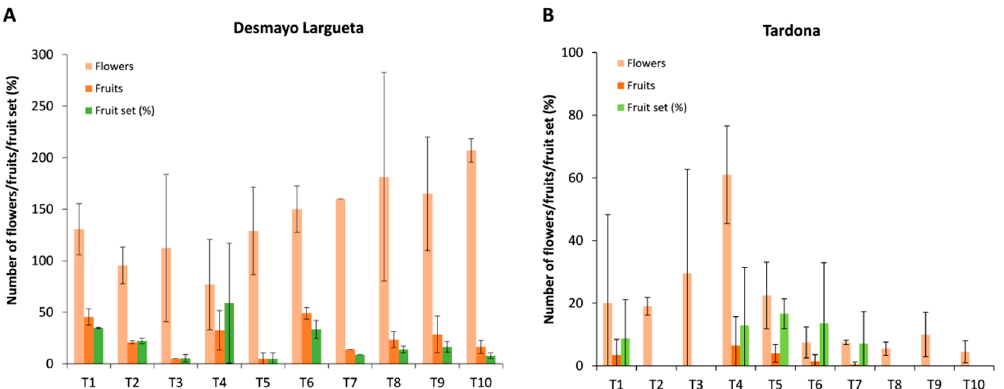
Figure 5. Mean number of flowers pollinated (light orange), mean number of fruits obtained (dark orange) and mean fruit set (green, %) ± SD per treatment (T) in Season 3. ( A ) Desmayo Largueta cultivar; ( B ) Tardona cultivar. Notice the different scale of A and B figures.